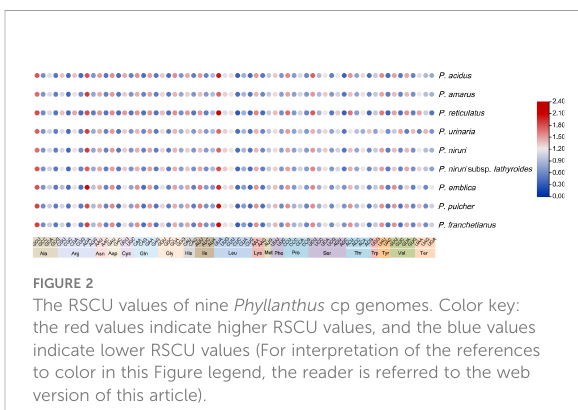
FIGURE 2 The RSCU values of nine Phyllanthus cp genomes. Color key: the red values indicate higher RSCU values, and the blue values indicate lower RSCU values (For interpretation of the references to color in this Figure legend, the reader is referred to the web version of this